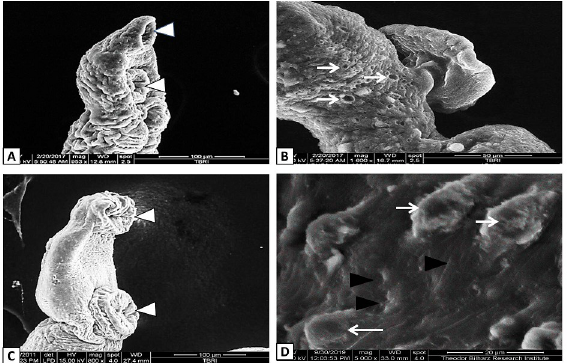
Fig 7. Scanning electron micrograph of dorsal surface of S . mansoni male worms recovered from A and B PZQ- treated mice (G6) showing deformed and swollen oral and ventral suckers (white arrow head), added to extreme deformity, more swelling, poring (white arrows) and furrows on the tegmental surface with flattening of tubercles and fall of spines; C and D PZQ with GNPs- treated mice (G7) showing abnormal swelling and flattening of oral and ventral suckers (white arrow head) in addition to blunt flattened tubercles and loss of spines (white arrow), with extensive erosion and cracking (black arrow head).